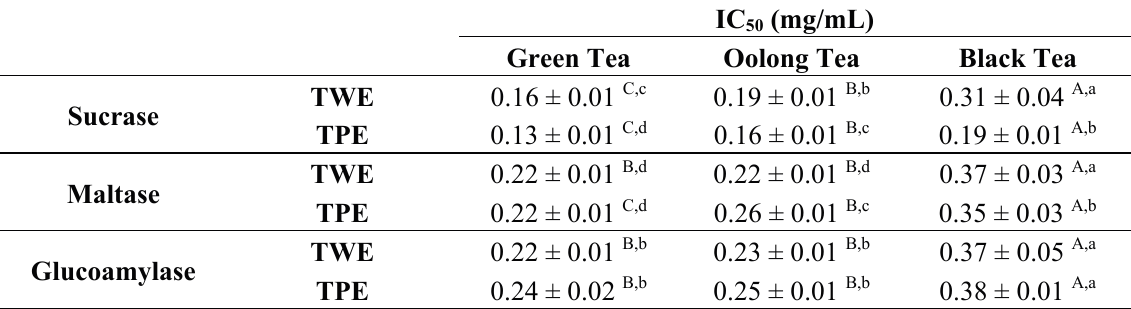
Table 2. Half maximal inhibitory concentration (IC 50 ) of tea water extract (TWE) and tea pomace extract (TPE) on rat small intestinal sucrase, maltase, and glucoamylase activity